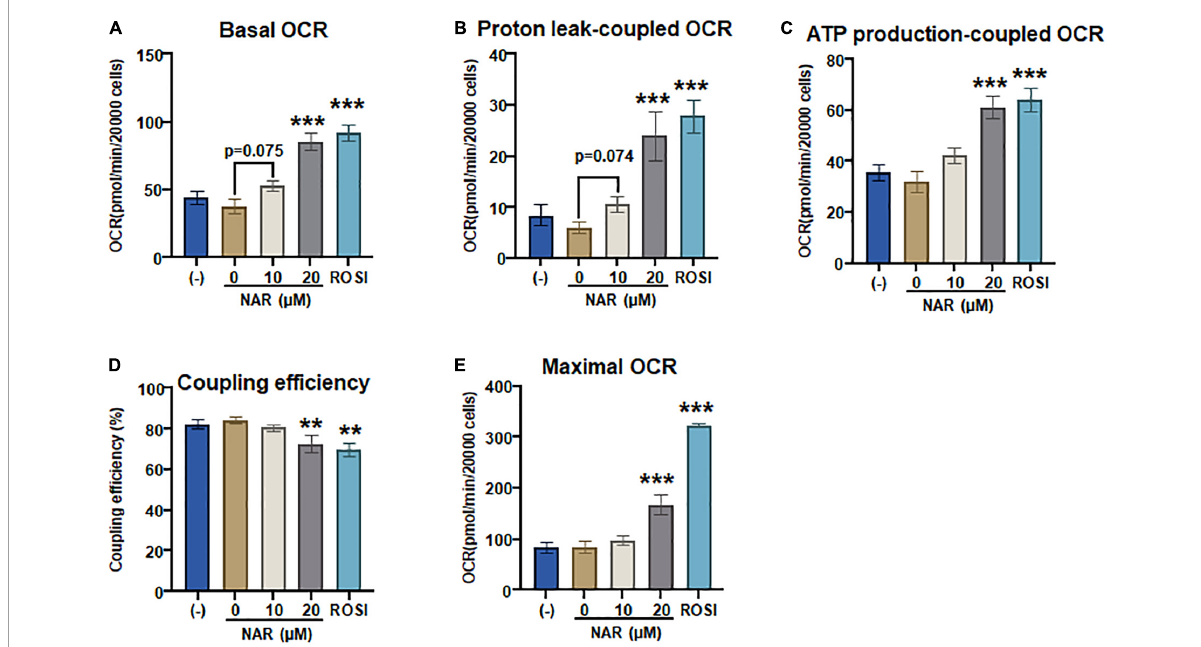
FIGURE8 Naringenin enhances mitochondrial respiration and uncoupling in murine brown adipocytes. (A–E) Murine brown pre-adipocytes were differentiated in the presence or absence of NAR (10 and 20 µ M) or ROSI (1 µ M) for 4 days. Then cells were reseeded at 20,000 cells per well into an XFe24 assay plate. After 24 h, the cells were then subjected to real-time measurements of OCR coupled with a mitochondrial stress test using an XFe24 Extracellular Flux Analyzer as described. Basal OCRs (A) , OCR linked to proton leak (B) and ATP production (C) , coupling efficiency (D) , and maximal respiration (E) were calculated and presented. Data = Mean ± SEM ( n = 3–7). *, **, *** p < 0.05, p < 0.01, and p < 0.001 compared to the 0 µ M NAR samples,